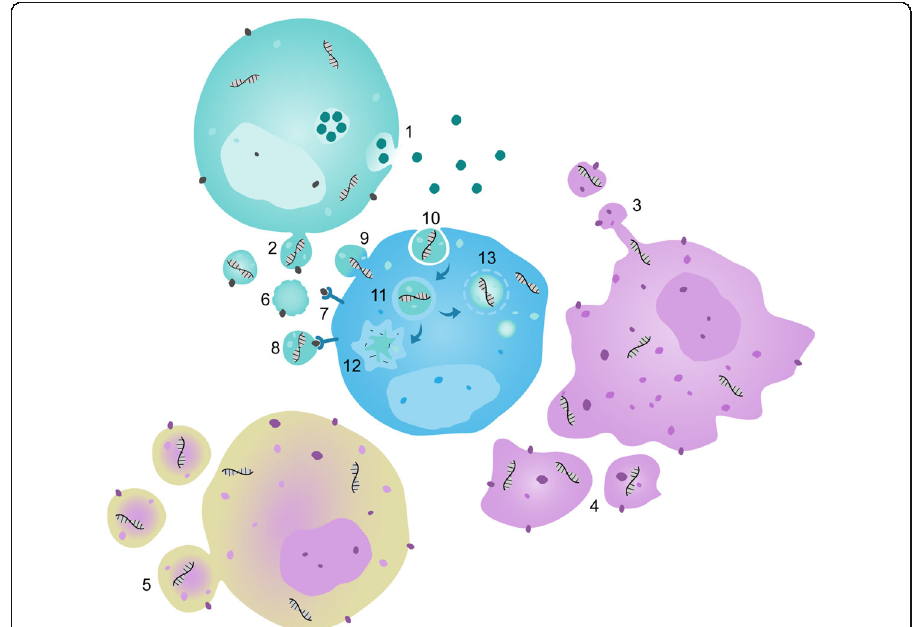
Fig. 2 Biogenesis of EVs and mechanisms of signal transduction. Exosomes are released from cells into the extracellular space by fusion of endosomes (multivesicular bodies) with the plasma membrane of the cell (1). In contrast, microvesicles are formed directly at the plasma membrane and bud from its lipid bilayer (2). In apoptotic cells, membrane protrusions are formed and release vesicles from their top (3), and apoptotic bodies of heterogenic size and morphology are generated as the cell dissolves (4). In tumor cells large EVs termed oncosomes can bleb of the plasma membrane into the extracellular space (5). There are several ways how EVs can transmit information to target cells: (i) they can undergo lysis in the extracellular space (6), releasing their cargo and membrane components, which can then bind to receptors on cell surfaces (7); (ii) surface molecules of intact EVs can stimulate receptors on target cells (8); and (iii) EVs can be incorporated by cells, and release their content through membrane fusion (9), or undergo endocytosis (10) being transferred into endosomes (11) with either lysosomal degradation (12), or escape from the endosome delivering the EV ’ s cargo into the target cell ’ s cytoplasm (13). Modified from “ Extracellular Vesicles: Unique Intercellular Delivery Vehicles ”